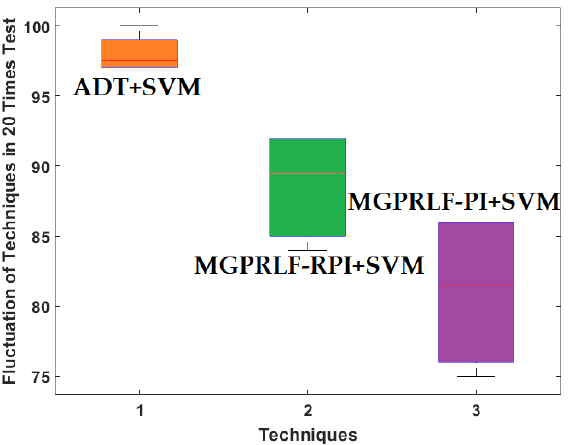
Figure 19. The average boxplots of crack size identification fluctuation (RF, IF, and OF) of the ADT+SVM, MGPRLF-RPI+SVM, and MGPRLF-PI+SVM to test the reliability and robustness of tests conducted 20 times.